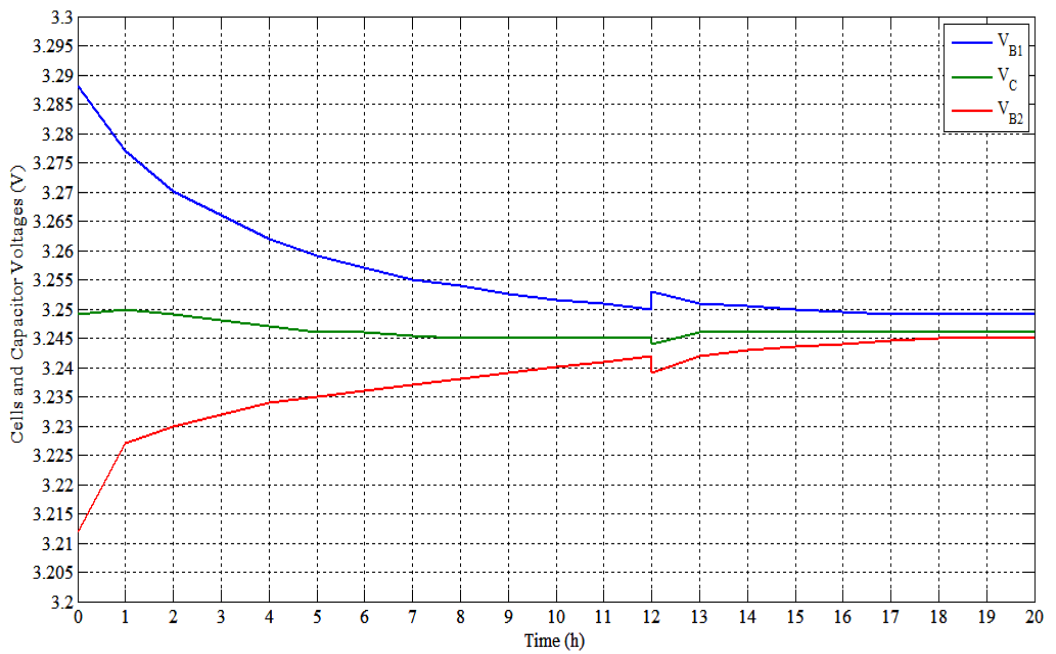
Figure 28. Experimental results of 2.3 A·h cells with SSC balancing (Test No. 3).